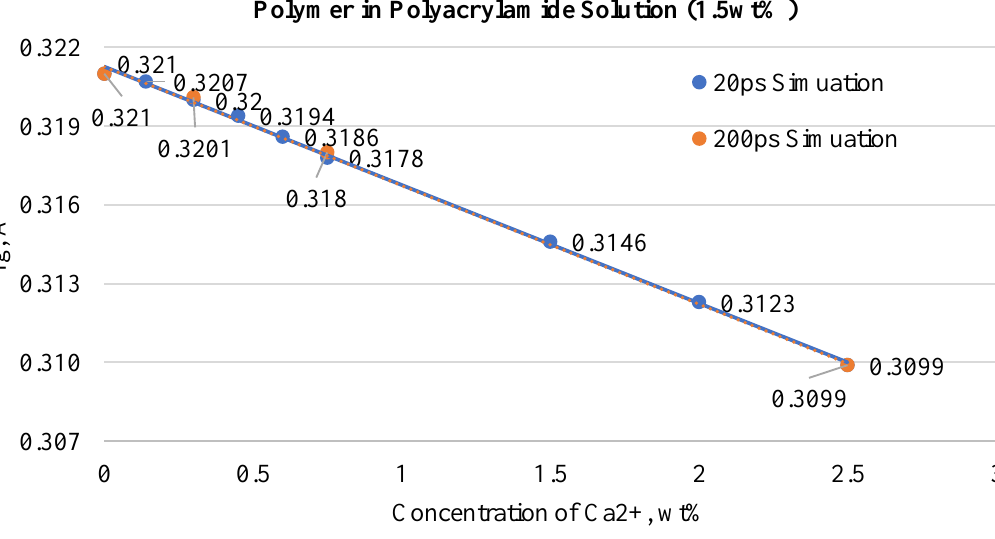
Figure 12—20 ps MD simulations vs. 200ps MD simulations in calcium chloride